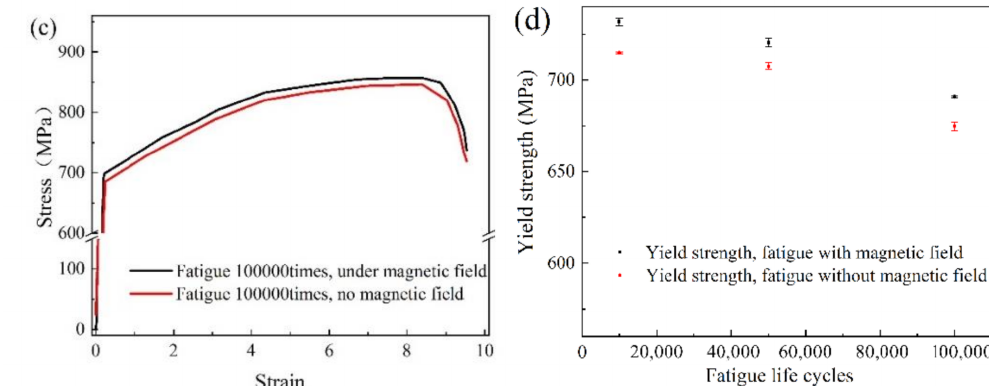
Figure 3. The stress–strain curves of specimens after fatigue life of 10,000 cycles ( a ), 50,000 cycles ( b ), 100,000 cycles ( c ), and yield strength conducted by different fatigue tests life cycles ( d ) under the load of 450 MPa.